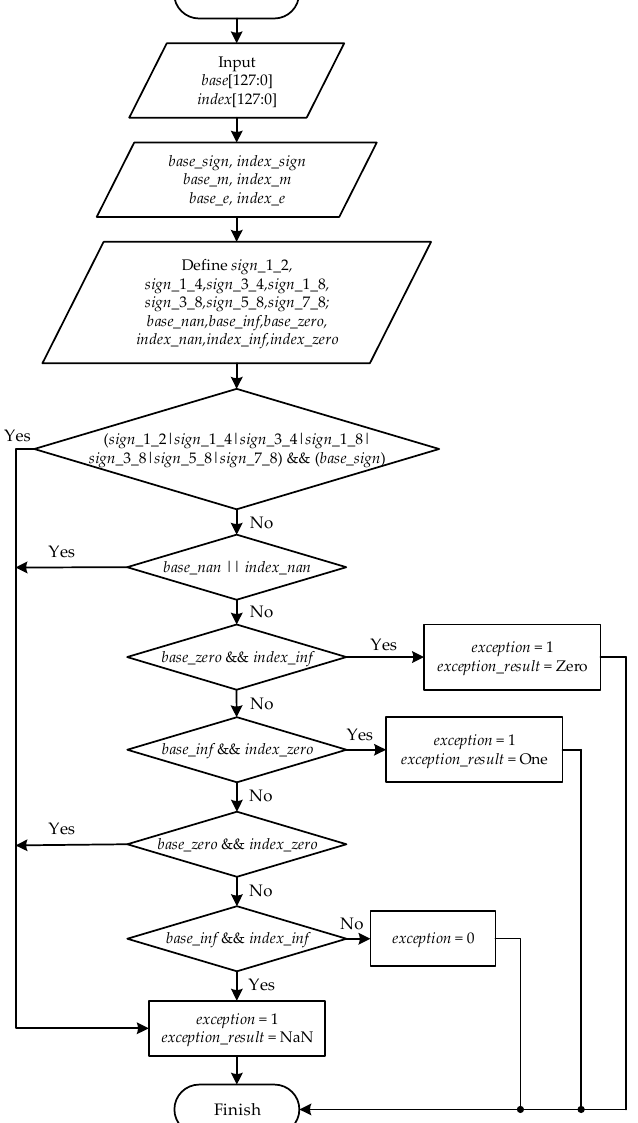
Figure 2. Program flowchart of the preprocessing module.